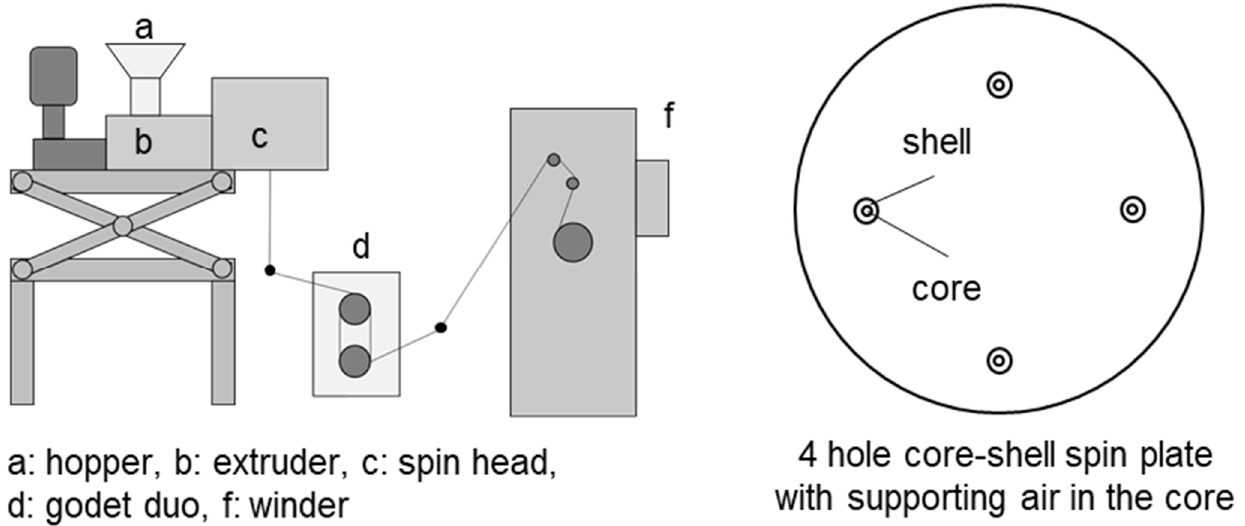
Figure 2. Installation for obtaining HF with a spinneret head with 4 coaxial holes with air supply to the internal space of the HF.